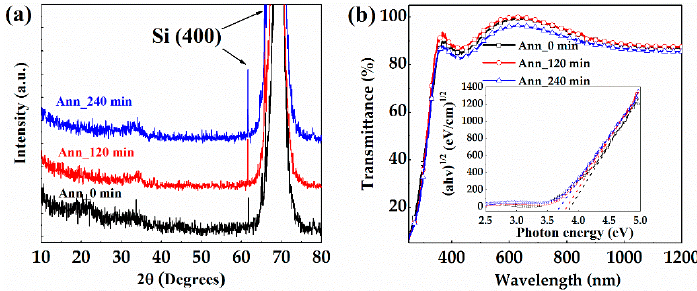
Figure 2. ( a ) XRD spectra of 0-, 120-, and 240-min annealed IGMO films; ( b ) transmittance spectra of a-IGMO films, the inset was the plots of ( α h ν ) 1/2 vs. h ν .